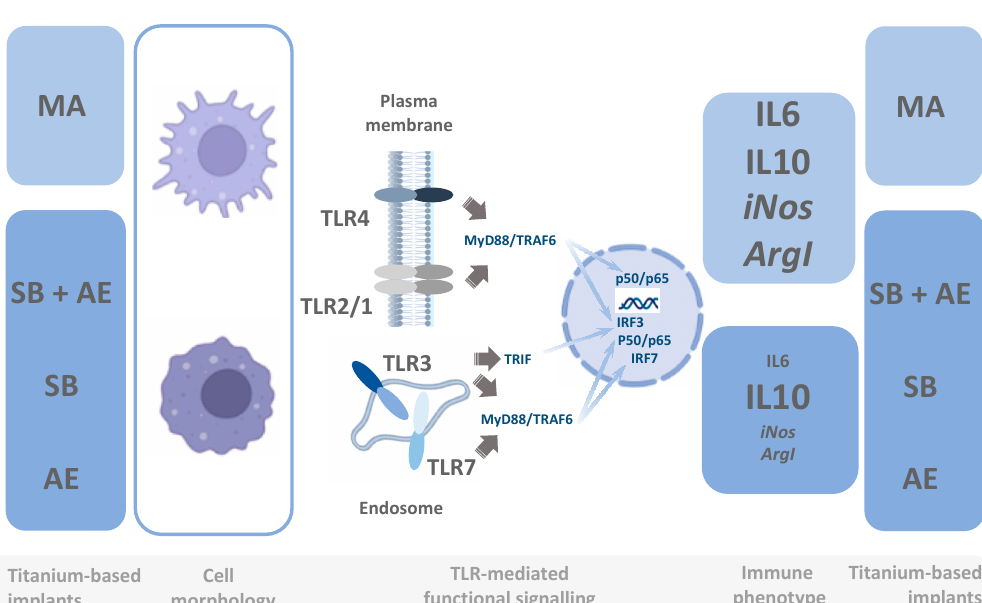
Titanium-based implants Figure 8. Potential mechanistic insights into Ti-discs caused the reprogramming of macrophages. TLR signaling imprinting of the MA-exposed macrophages displays differential functional responses compared to SB + AE, SB and AE titanium-based materials after membrane or endosomal TLRs elicited by specific ligands (LPS for TLR4, synthetic bacterial triacylated lipoprotein for TLR2/1, poly I:C for TLR3 and imiquimod for TLR7). TLR downstream signaling regulated by titanium-based dental materials affects both the MyD88-dependent and MyD88-independent pathways, suggesting a potential role in IRF3-, IRF7- and p50/p65-mediated control of the transcriptional activity. Abbreviations: MyD88, MyD88 innate immune signal adaptor protein; TRAF6, TNF receptor-associated factor 6; TRIF, TIR-domain-containing adapter-inducing interferon- β ; IRF3, interferon regulatory factor 3; IRF7, interferon regulatory factor 7; p50/p65, subunits of NF-kappa B nuclear transcription factor; MA, mechanical abrasion; SB, sandblasting plus etching; SB, sandblasting; AE, acid etching.